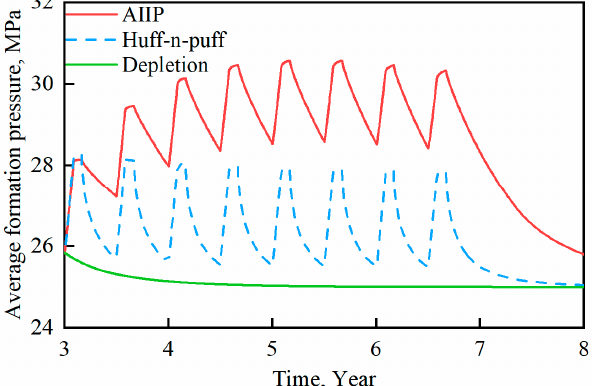
Figure 6. Comparisons of cumulative oil production in different development modes.